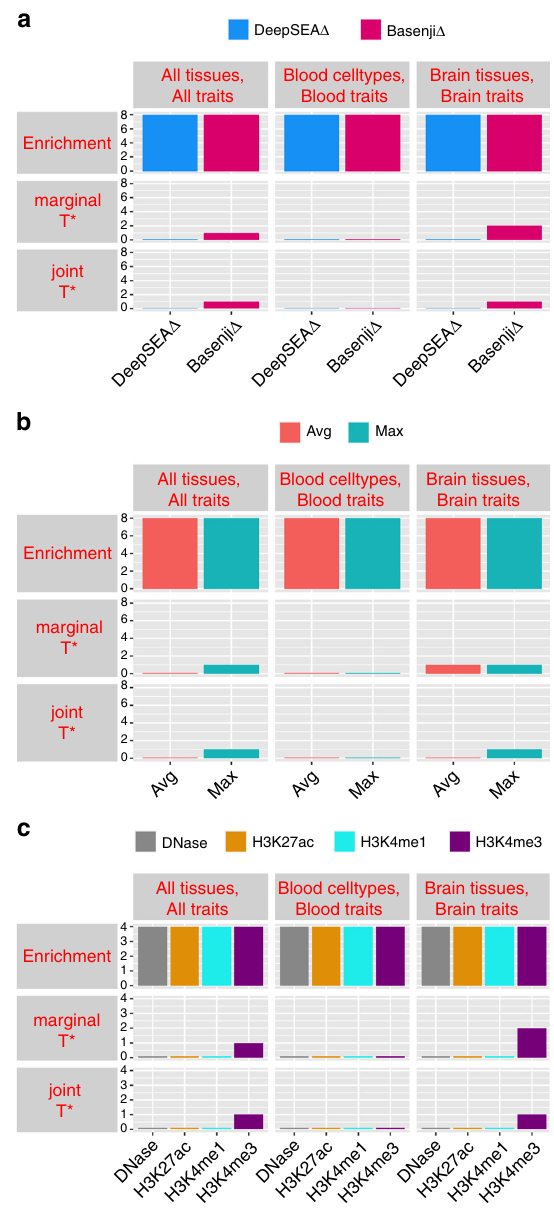
Fig. 1 Summary of disease informativeness of allelic-effect deep learning annotations. We report the number of allelic-effect annotations with signi fi cant heritability enrichment, marginal conditional τ ⋆ , and joint conditional τ ⋆ , across a different deep learning models (DeepSEA/Basenji), b different aggregation strategies (Avg/Max) and c different chromatin marks (DNase/H3K27ac/H3K4me1/H3K4me3). Numerical results are reported in Supplementary Table 5 (numerical summary of results), Supplementary Table 6 (enrichment and marginal τ ⋆ for all tissues, all traits analysis), Supplementary Table 15 (enrichment and marginal τ ⋆ of blood cell types, blood traits analysis), Supplementary Table 21 (enrichment and marginal τ ⋆ of brain tissues, brain traits analysis) and Supplementary Table 27 (joint τ ⋆